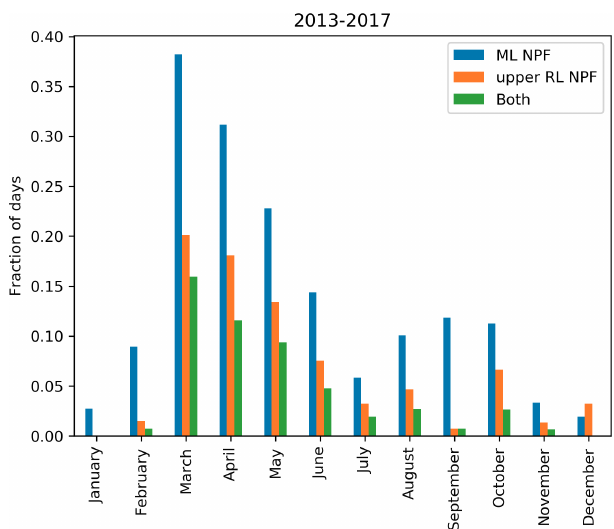
Figure 9. Monthly fractions of NPF within the ML and NPF in the upper RL in Hyytiälä between